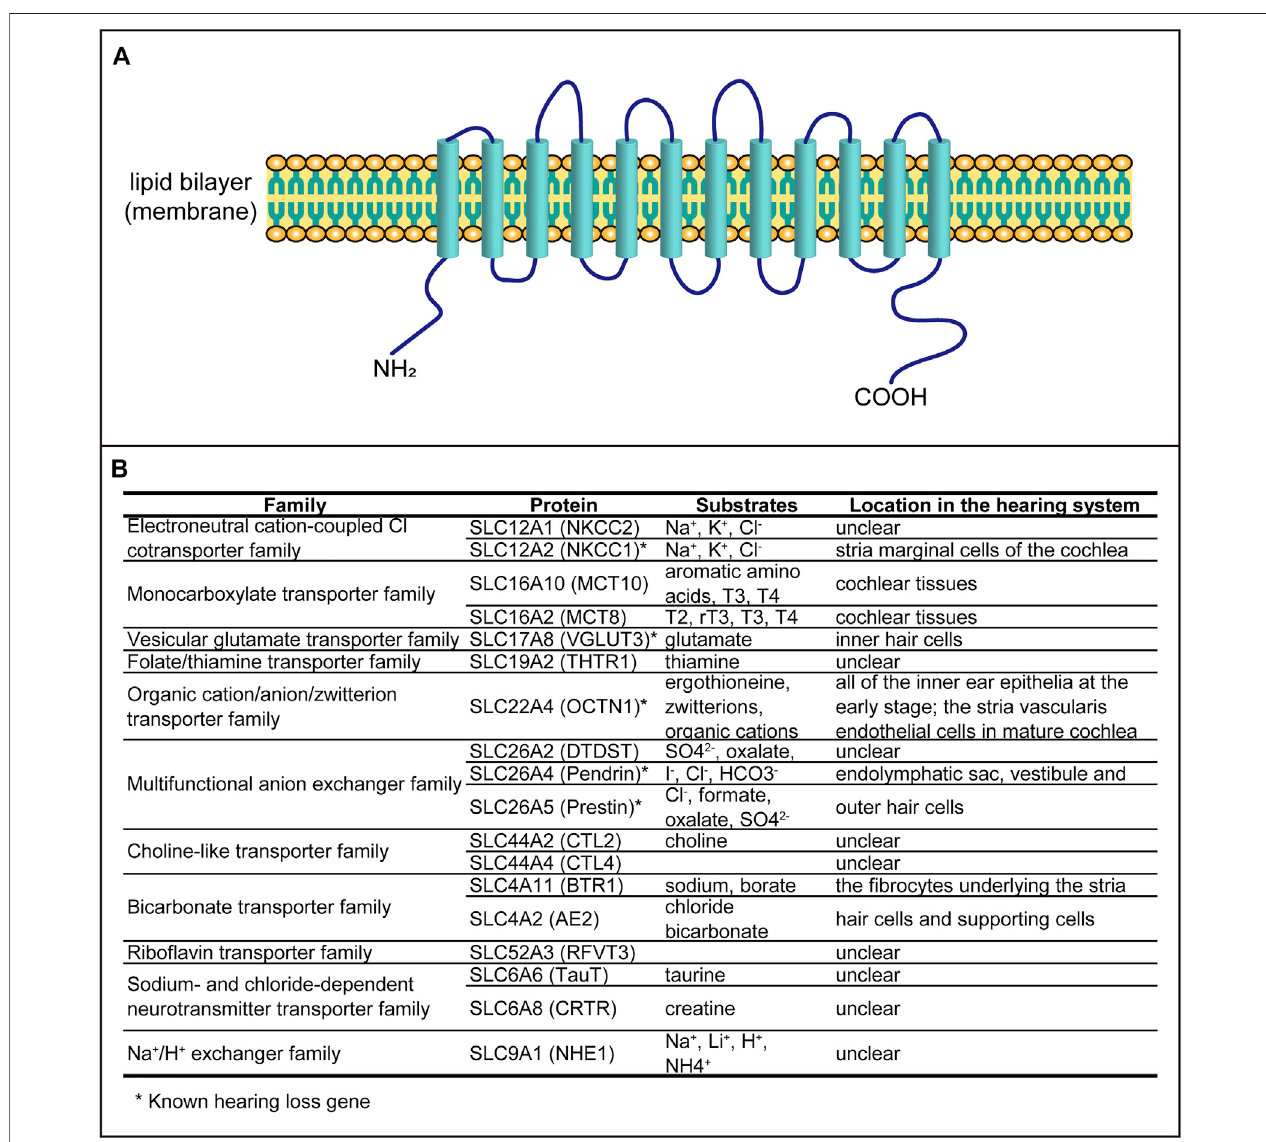
FIGURE 1 | SLC proteins involved in auditory function. (A) Schematic structure of the transporter containing 12 transmembrane domains. (B) All SLC proteins associated with hearing dysfunction.